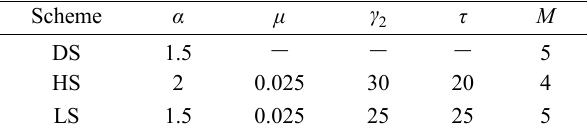
Table 6 Optimal parameter settings for DABC with different search schemes.